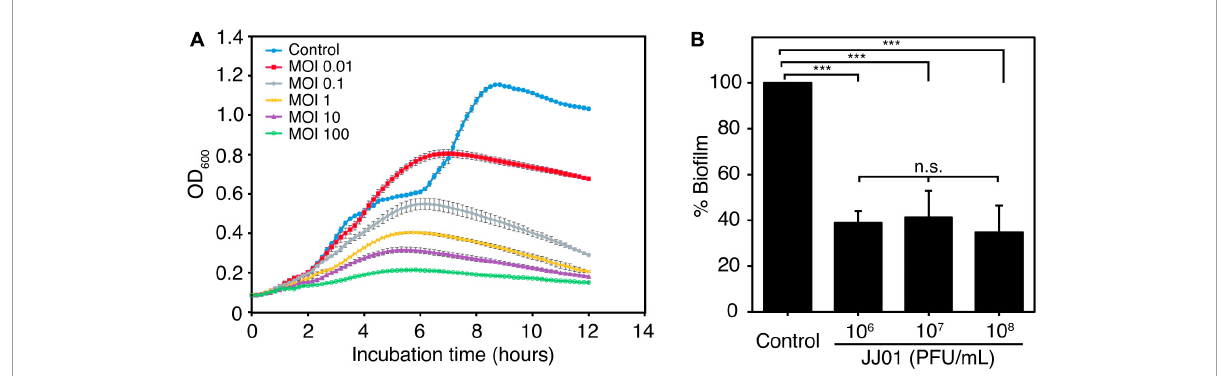
FIGURE4 (A) Killing assay shows the ability of phage JJ01 to lyse P. aeruginosa cells at different multiplicity of infections (MOIs) at 0.01, 0.1, 1, 10, and 100 in LB medium at 37 o C for 12 h. Each experiment was performed in triplicate. Data and error bars were represented as the mean ± standard deviation. (B) Biofilm eradication assay. Crystal violet staining reveals the grown biofilm level of P. aeruginosa PAO1 after incubation with phage JJ01 at 10 6 , 10 7 , and 10 8 PFU/mL for 48 h compared with the control (absence of phage JJ01). Asterisks represent significant differences in